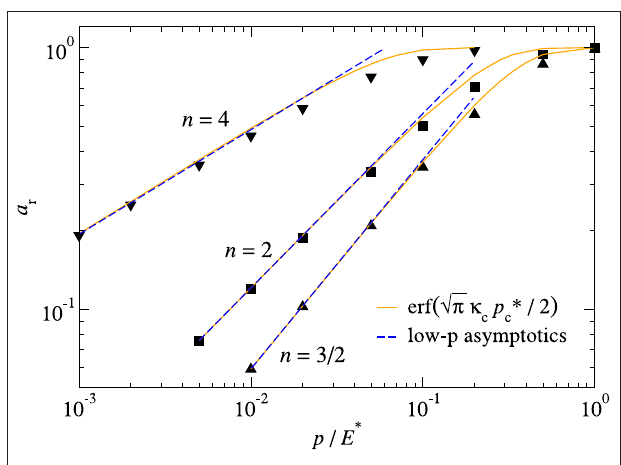
FIGURE 9 | Relative contact area a r as function of pressure p normalized to the contact modulus E ∗ for periodically repeated indenters with the height R ( r / R ) n / n , where R defines the unit of length and with n profile h ( r ) = (blunt indenter), n 2 (Hertzian indenter), and n =